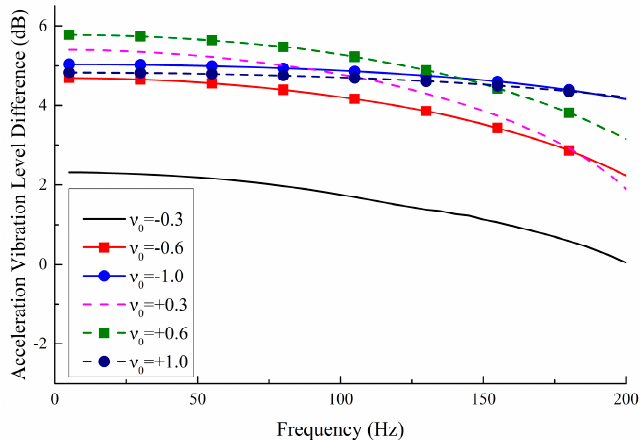
Figure 14. Average vibration reduction performance of the metamaterials with various PR.